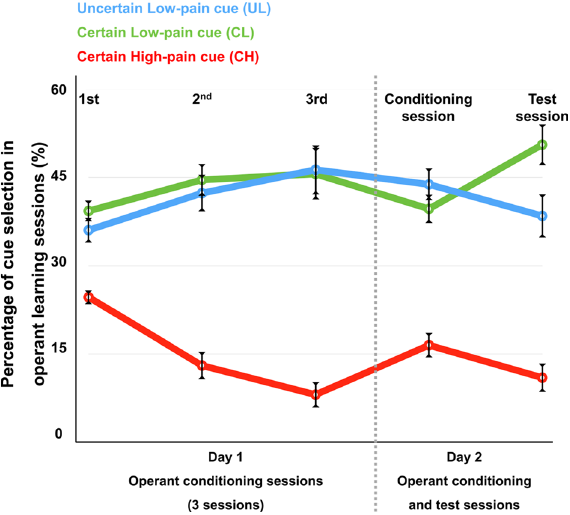
Figure 1. Operant learning of visual cues. Error bars represent between-subject standard errors. Participants preferred cues predicting low pain to those predicting high pain regardless of the certainty of the cues, suggesting that the participants learned the association between visual cues and pain levels through operant conditioning (UL vs. CL: t = −1.36, p = 0.54; UL vs. CH: t = −7.20, p = 3.4e−09; CL vs. CH: t = −5.84, p = 6.7e−07).